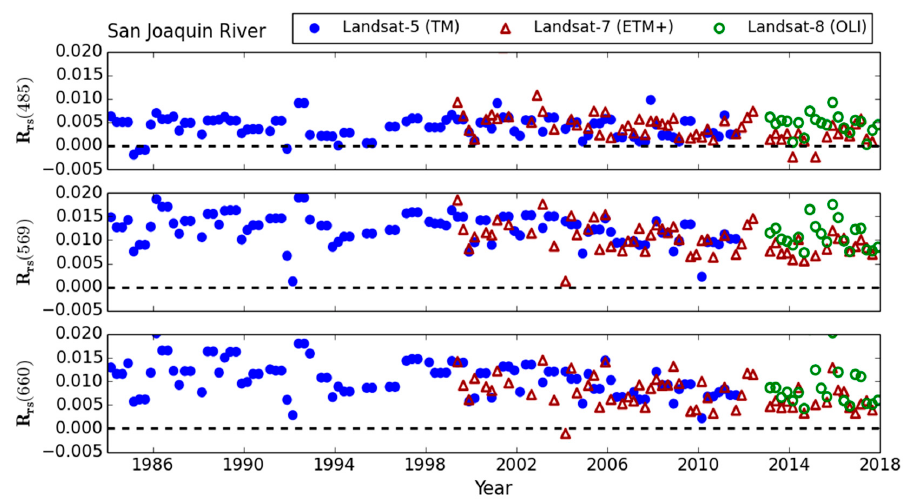
Figure 12. Seasonal R rs composites derived from Landsat-5 (solid circles), Landsat-7 (triangle), and Landsat-8 (hollow circles) in San Joaquin River (38.09182N, 121.6297W), California. The composites were obtained by taking the median of retrievals in each season. The images were processed via SeaDAS. The product consistency can be inferred in the cross-mission overlapping periods. Few negative retrievals are attributed to imperfect corrections for the contributing water-leaving radiance in the NIR